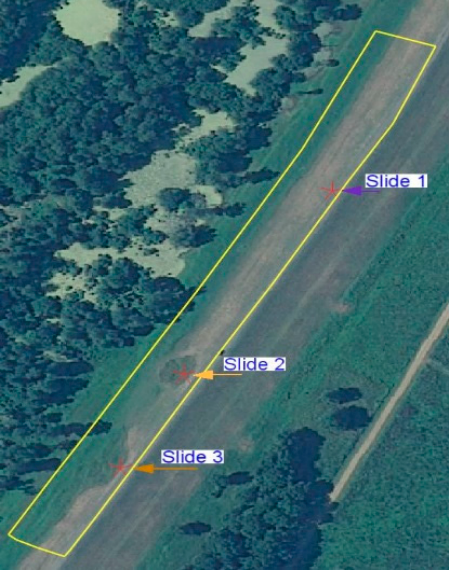
Figure 5. Optical image overlaid with the test area in yellow.